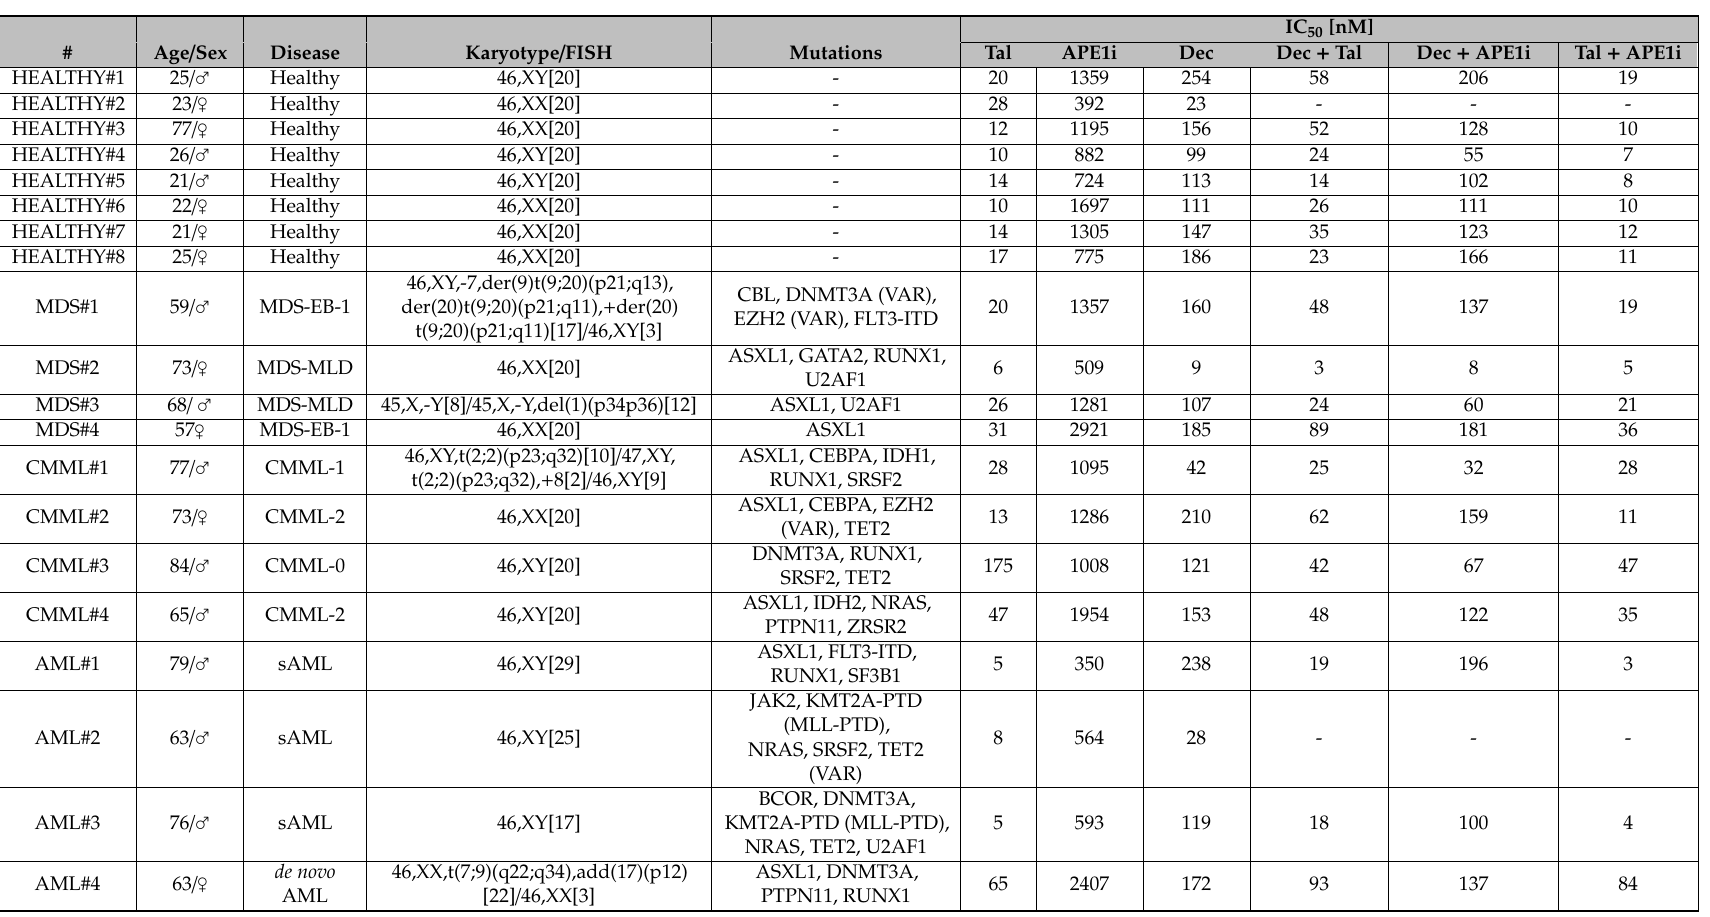
Table 1. Characterization of myelodysplastic syndrome / chronic myelomonocytic leukemia and acute myeloid leukemia bone marrow samples. APE1i: APE1 inhibitor III; CMML-0 / 1 / 2: chronic myeloid leukemia-0 / 1 / 2; Dec: decitabine; FISH: fluorescence in situ hybridization; IC 50 : half maximal inhibitory concentration; MDS-EB-1: myelodysplastic syndrome with excess blasts; MDS-MLD: myelodysplastic syndrome with multilineage dysplasia; sAML: secondary acute myeloid leukemia; Tal: